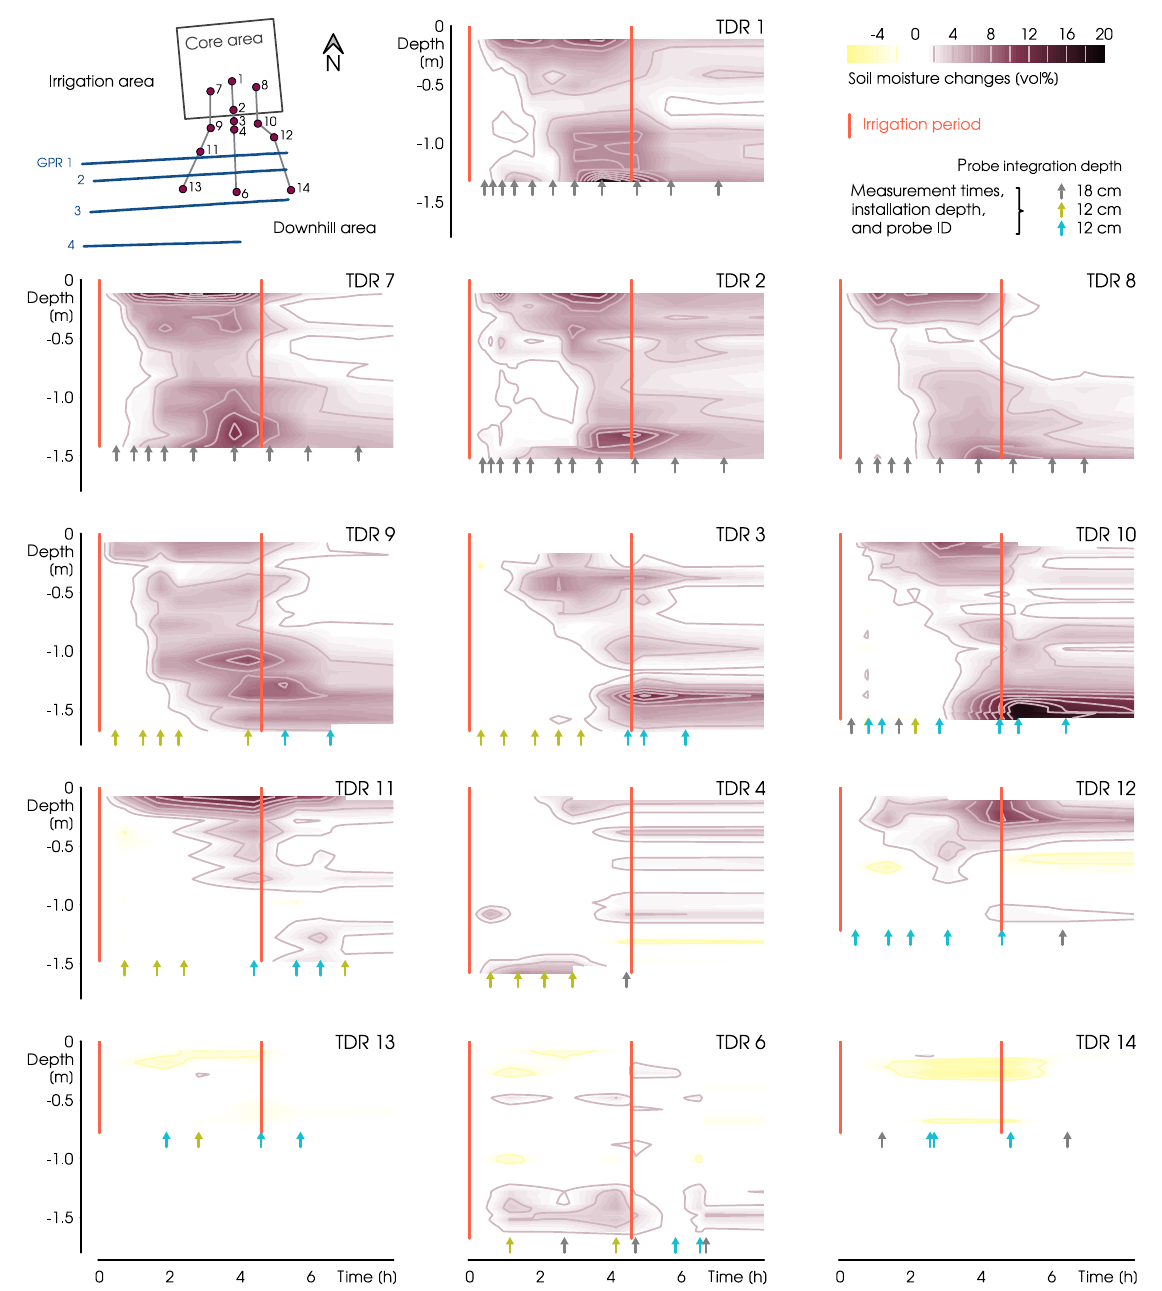
Figure 8. The soil moisture data measured at the TDR profiles at the irrigation site, showing the soil moisture dynamics in depth. The top four plots show all four core area profiles; columns are arranged according to the three diverging transects in the downhill direction. Rows are approximately at the same contour line. Measurements were taken at 0.1m increments. While data analysis was based on non-interpolated data, soil moisture measurements were here interpolated linearly for better visualization. The plots cover the time from irrigation start until 9:00h after irrigation start to focus on the first soil moisture response. Arrows indicate the measurement times and installation depth of each TDR profile. Time is given in hours after irrigation